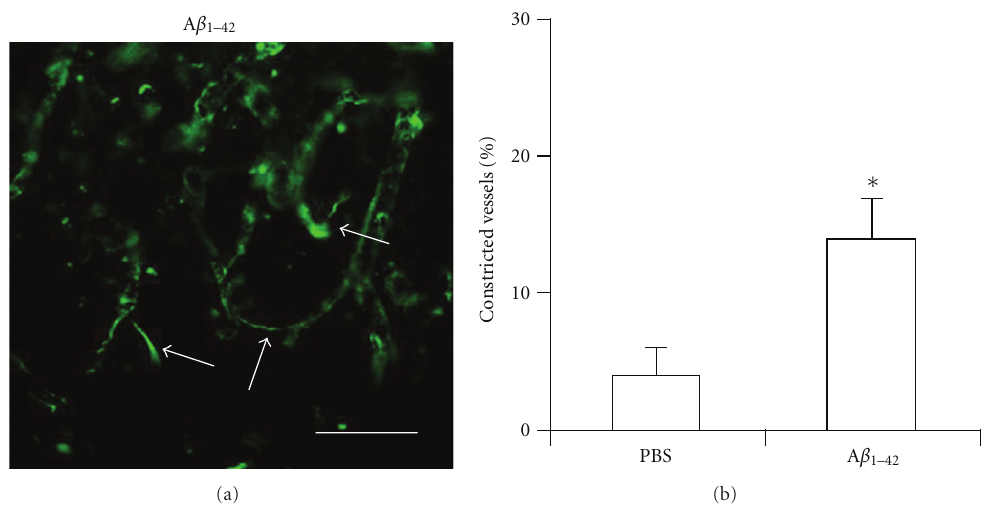
Figure 3: Constricted microvessels in A β 1 − 42 -injected hippocampus. (a) Laminin immunoreactivity showing examples of constricted microvessels (indicated by arrows). The scale bar is for 50 μ m. (b) Bar graph showing % of constricted microvessels for PBS control and